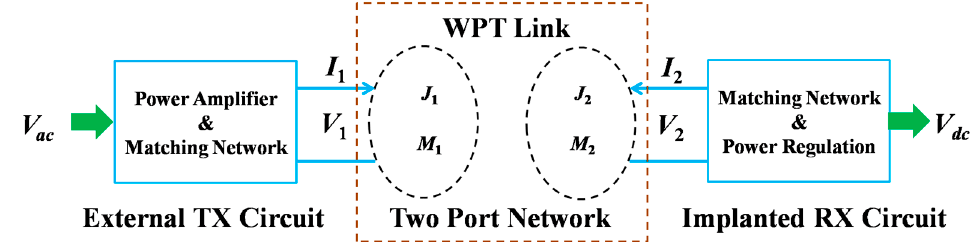
Figure 29. Complete NRRMF WPT system [158]. The input signal is feed to the TX antenna by a power amplifier following by a matching network. The RX antenna is connected with a matching network, and the output signal is processed through a power regulation circuit.